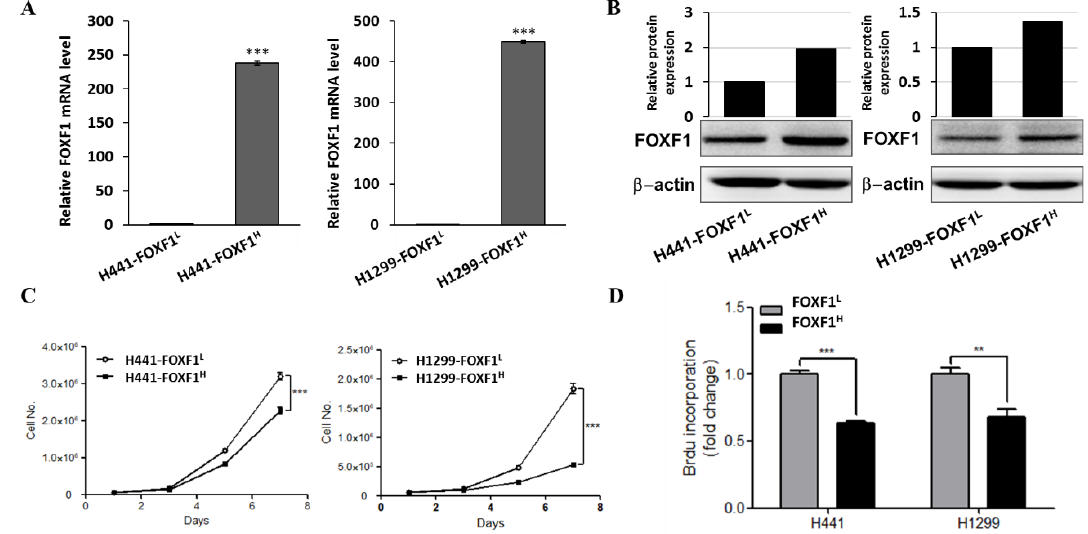
Figure 2. Proliferation ability of highly expressing FOXF1 non-small-cell lung cancer cell lines. Determination of relative expression levels of ( A ) FOXF1 mRNA, ( B ) protein, ( C ) cell growth, and ( D ) BrdU incorporation assay-based in vitro cell proliferation of H441-FOXF1 H and H1299-FOXF1 H cell lines compared to their respective controls (H441-FOXF1 L and H1299-FOXF1 L ). β-actin served as a loading control. Data are expressed as means ± SE. ** p < 0.01; *** p < 0.001, using Welch’s unpaired t- test.